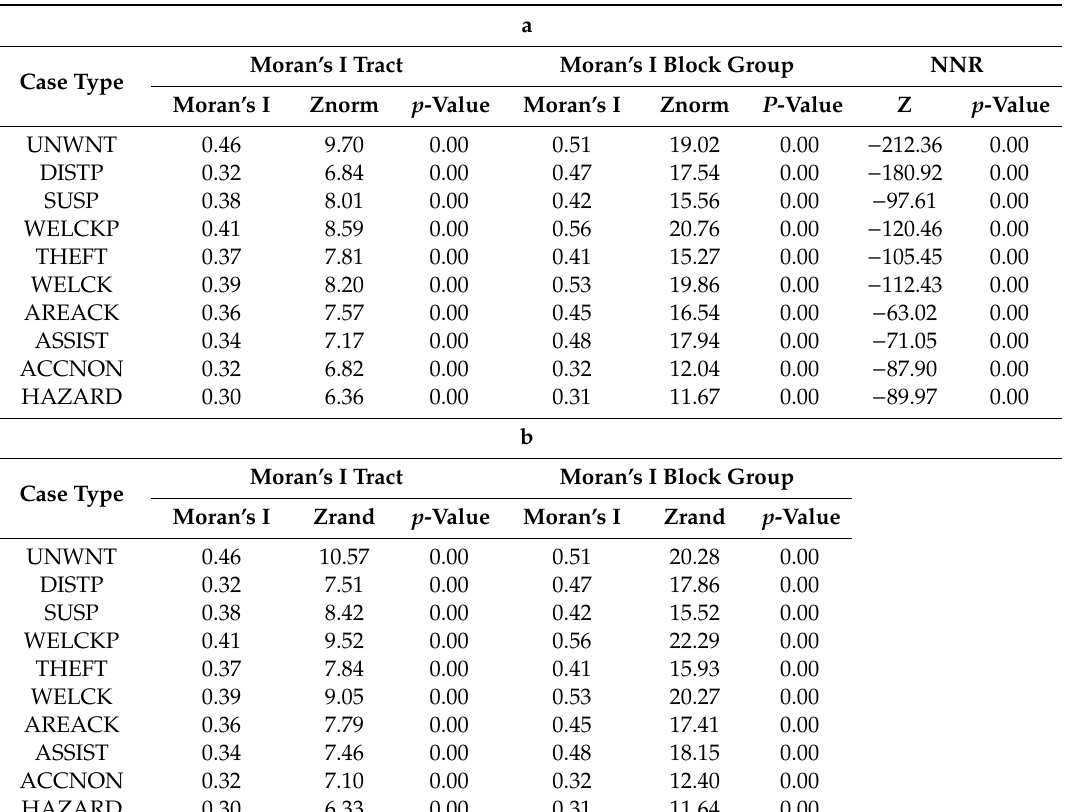
Table 6. (a) Classical spatial pattern of call for service record (Znorm is the Z-score calculated under normality assumption). (b) Classical spatial pattern of call for service record (Zrand is the Z-score calculated under randomness